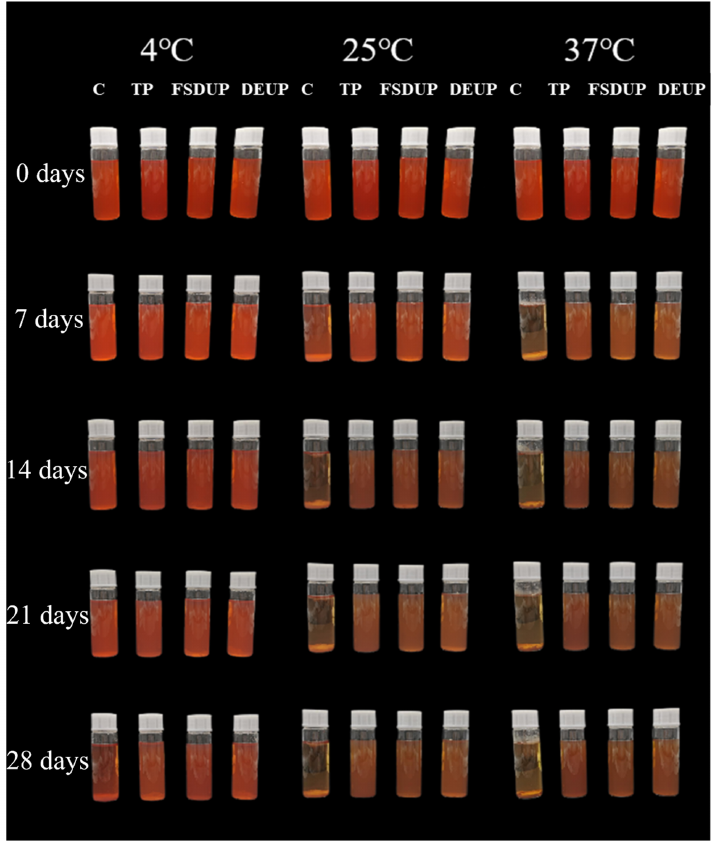
Figure 3. Changes in apparent morphology of strawberry clear juice during storage after thermal pretreatment and multi-mode thermosonication. C: control; TP: thermal pretreatment; FSDUP: flat sweep-frequency dispersive ultrasound pretreatment; DEUP: dual-frequency energy-gathered ultrasound pretreatment.